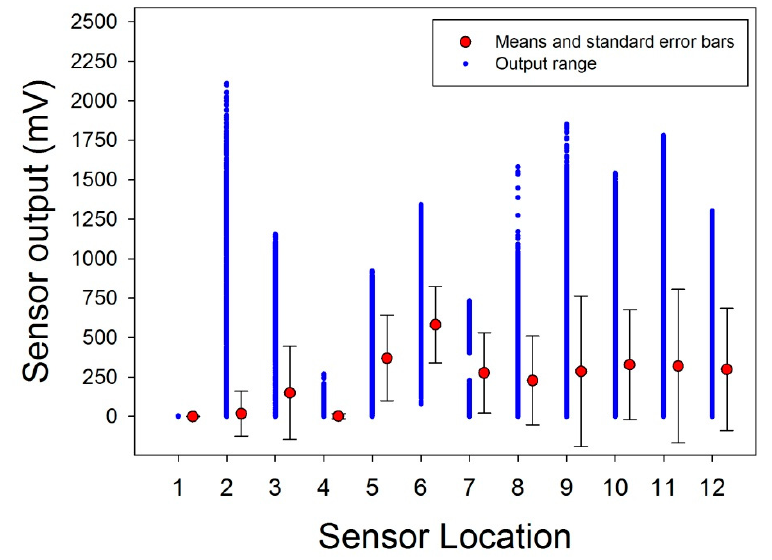
Figure 5. Means, standard errors, and output range between minima and maxima recorded from each of the twelve sensor locations across users and hands.